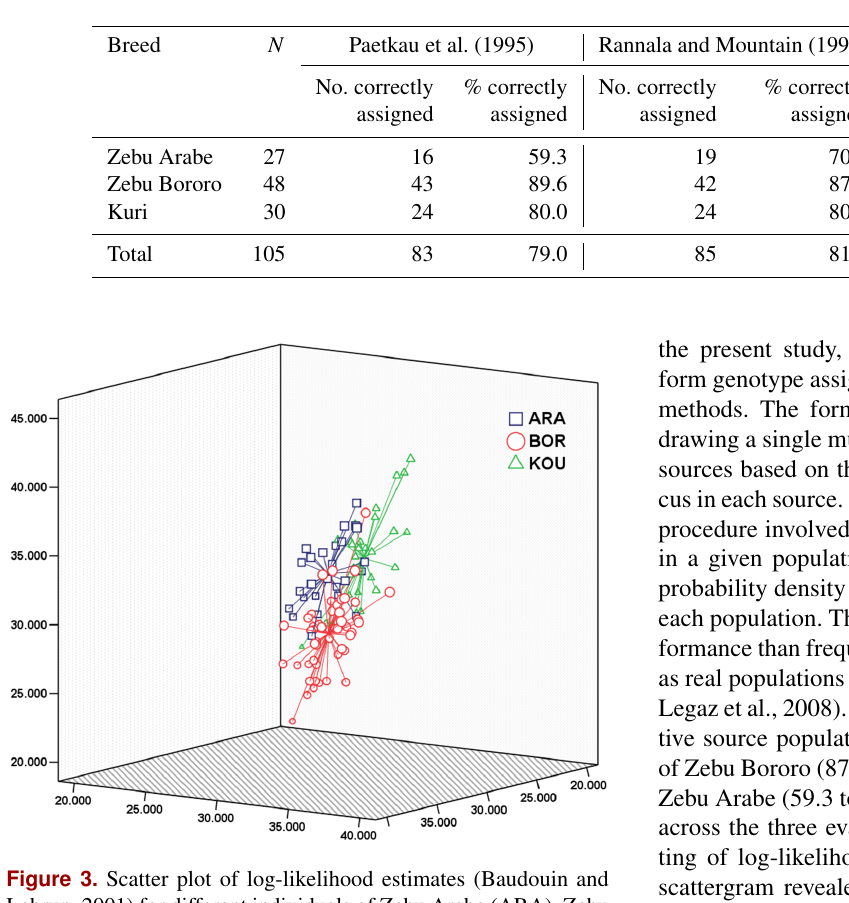
Table 4. Genotype assignment of Zebu Arabe, Zebu Bororo and Kuri breeds of Niger cattle.